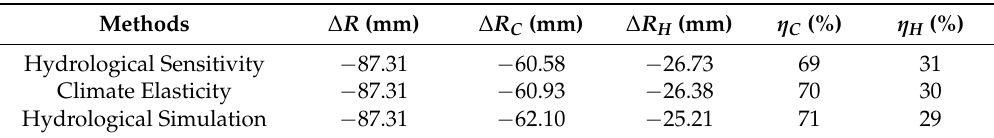
Table 4. Effects of climate variability and human activities on mean annual runoff for the impacted period, as estimated using different